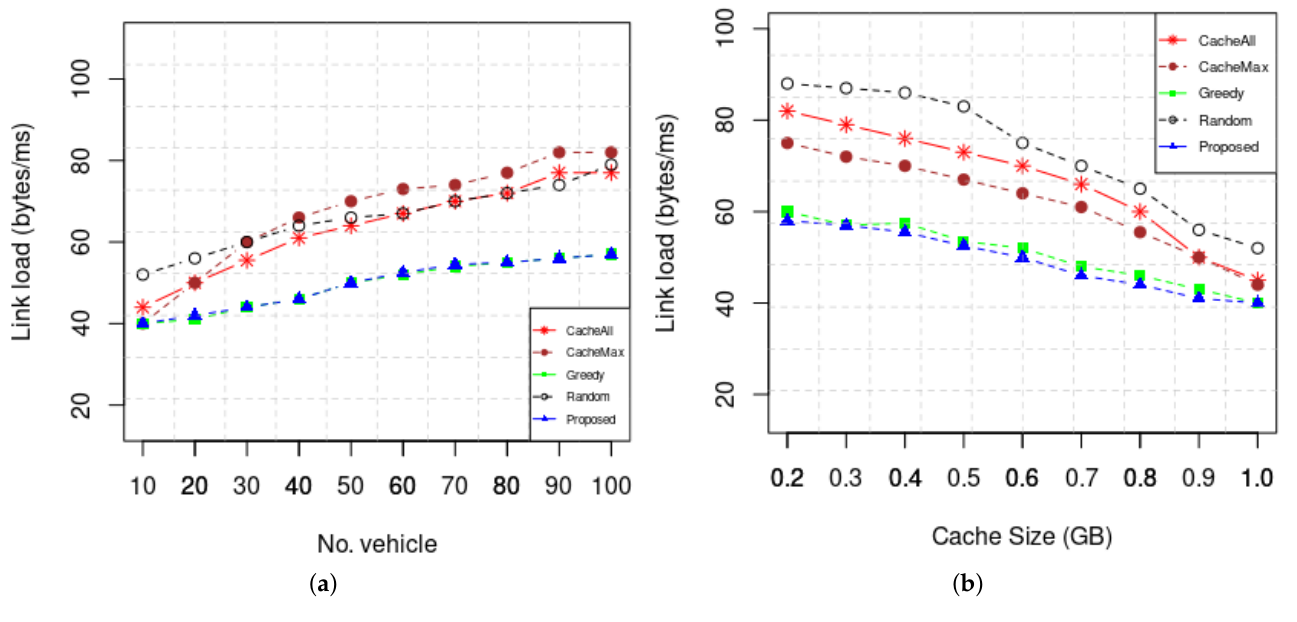
Figure 8. ( a ) Link load vs. number of vehicles and ( b ) cache